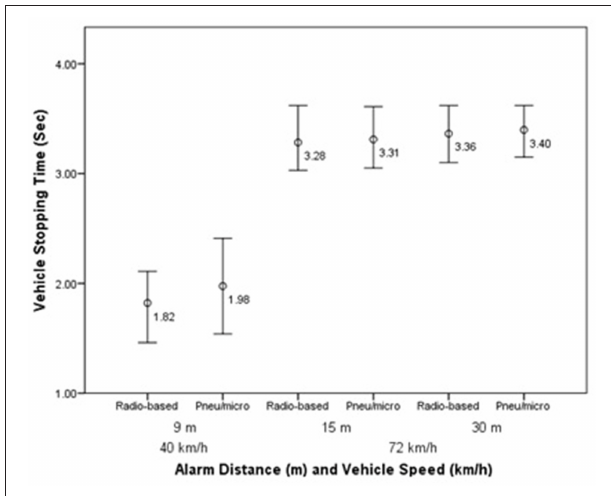
FIGURE 6 | Results of vehicle stopping